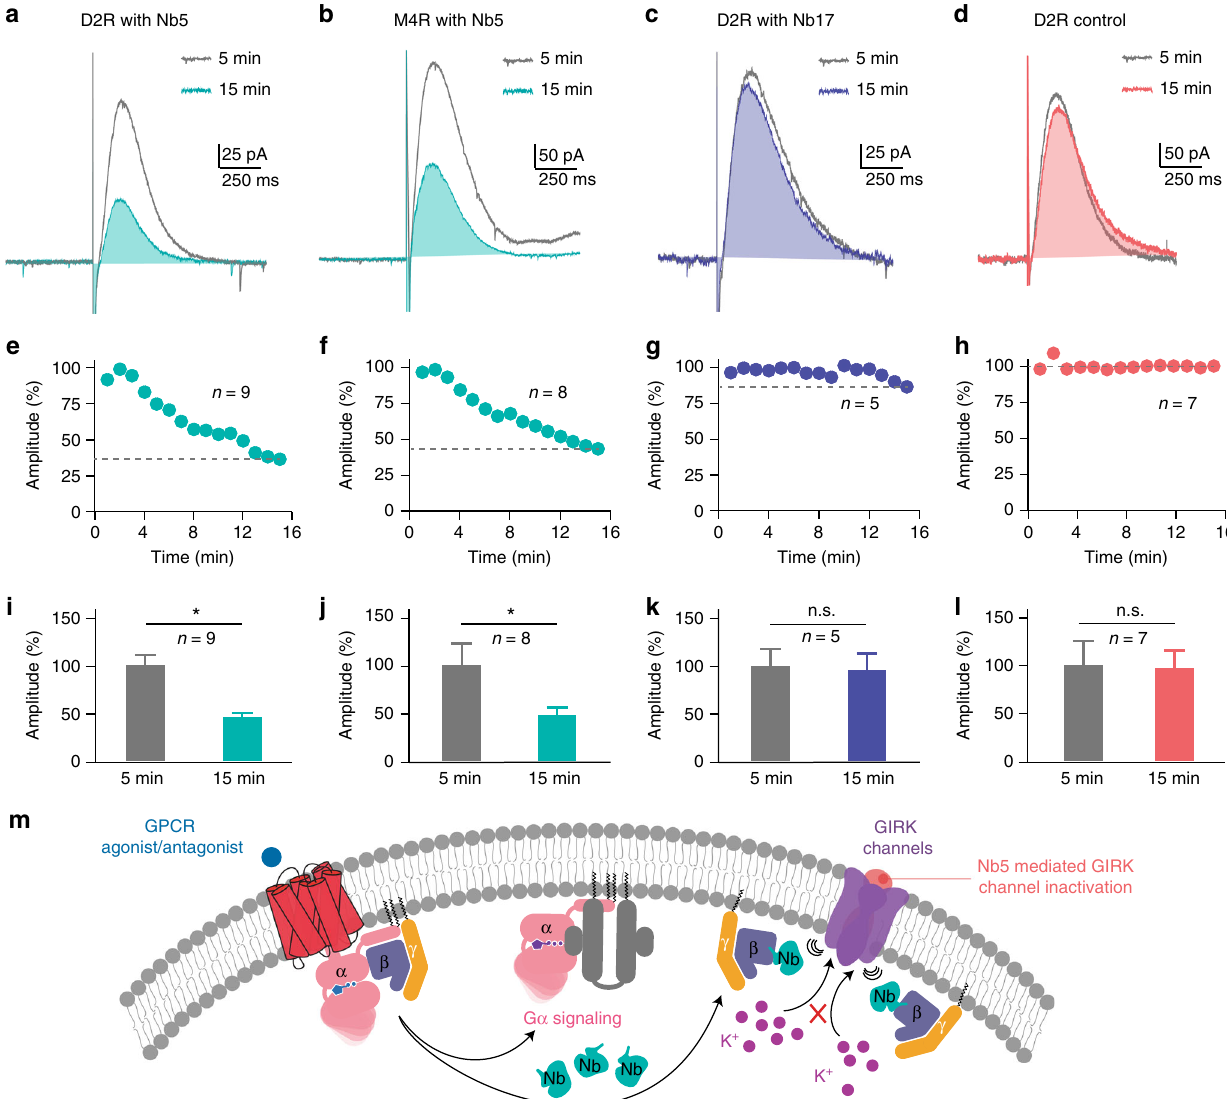
Fig. 5 Inhibition of G βγ -mediated GIRK signaling by Nb5. a Representative whole-cell recording of a GIRK2 + striatal medium spiny neuron (MSN) treated with 10 μ M of intracellular Nb5. A single electrical stimulation evoked a D2R-IPSC that showed a signi fi cant amplitude reduction 15 min post-treatment with Nb5 (greencyan) as compared to the averaged trace observed at 5 min post-treatment with Nb5 (grey). b Representative trace of an M4-IPSC that displays an amplitude reduction 15 min post-treatment with Nb5 (greencyan) as compared to the averaged trace observed at 5 min post-treatment with Nb5 (grey). But no signi fi cant change was noted in D2R-IPSC either exposed to 10 μ M intracellular Nb17 ( c ) or without nanobody treatment ( d ). Time course measurements showing a decrease in D2R-IPSC ( e ) and M4R-IPSC ( f ) amplitudes upon their exposure to 10 μ M Nb5. Time course measurements of D2R-IPSC amplitudes recorded either with Nb17 ( g ) or without nanobody treatment ( h ). Bar graph quanti fi cation of D2R-IPSC ( n = 9) ( i ) and M2R-IPSC ( n = 8) ( j ) amplitudes recorded with Nb5. Bar graph quanti fi cation of D2R-IPSC amplitudes ( n = 5) recorded either with 10 μ M Nb17 ( k ) or without nanobody treatment ( l ), revealing no signi fi cant change in amplitudes over 15 min. Results are expressed as the mean ± SEM. * P < 0.05, Student ’ s t -test